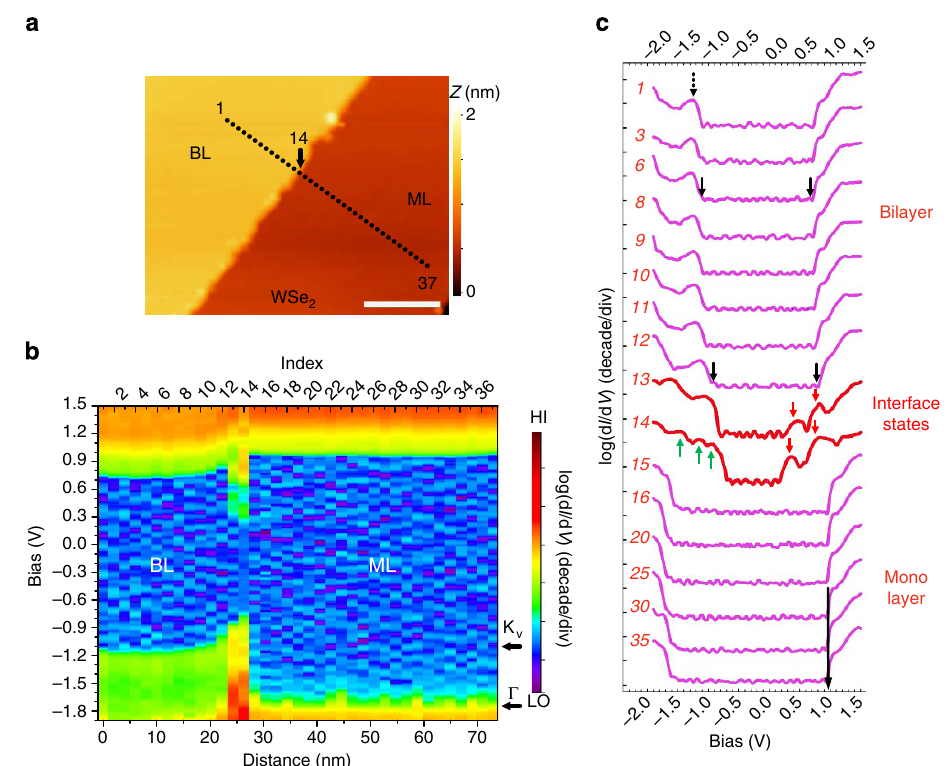
Figure 2 | Scanning tunnelling spectroscopy investigation of band profile across the BL–ML WSe 2 heterojunction. d I /d V spectra were taken along the path shown in ( a ). The spectra numbers are labelled (counting from left to the right in the path line). The total length is roughly 73nm with a step size of 2nm. Spectrum #14 was taken right at the interface. ( b ) Colour-coded rendering of the real space imaging of band profile plotted in terms of log(d I /d V ). All spectra in this paper are displayed with arbitrary units (a.u.), except for Fig. 4c. The energy locations of G and K V (actual VBM) points are labelled by black arrows. ( c ) A selective subset of log(d I /d V ) spectra. In spectrum #1, the upper state of G splitting, which results from interlayer coupling, is labelled with a black dashed arrow. The interface states are marked in spectrum #13 and #14 with red arrows for conduction band side and green arrows for valence band side. A black arrow in monolayer region represents for the energy location of CBM. Scale bar, 20nm ( a